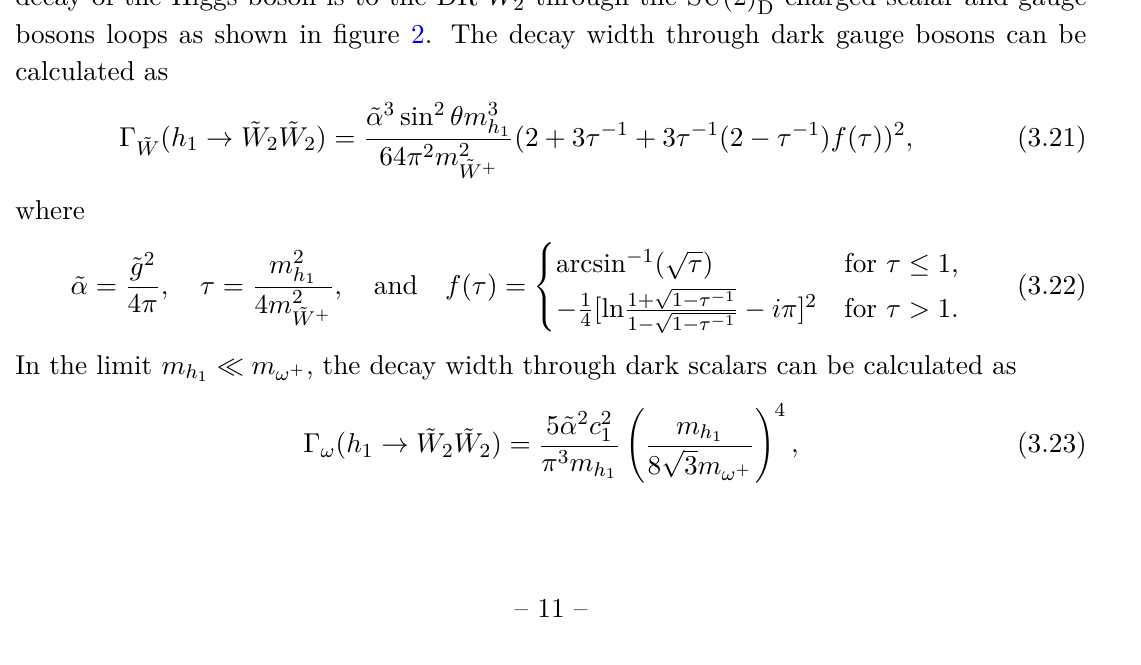
Figure 1. Upper bounds on the mixing angle | sin θ | versus the heavy Higgs mass m h horizontal purple line is from the Higgs signal rate measurement [83]. The yellow shaded region shows the upper bound from the direct searches for the heavy Higgs at LEP and LHC ( 7 TeV) [84]. The blue (red) shaded regions are excluded by the LHC di-boson searches with VBF (ggF) channels. The blue and red dashed lines correspond to the HL-LHC projection for these two channels, respectively [85]. The grey shaded area labelled by W mass, and the area above the brown dashed line labelled by S, T, U are excluded by the electroweak precision observables